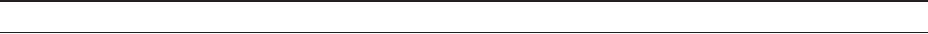
Table 4. Bray-Curtis similarity